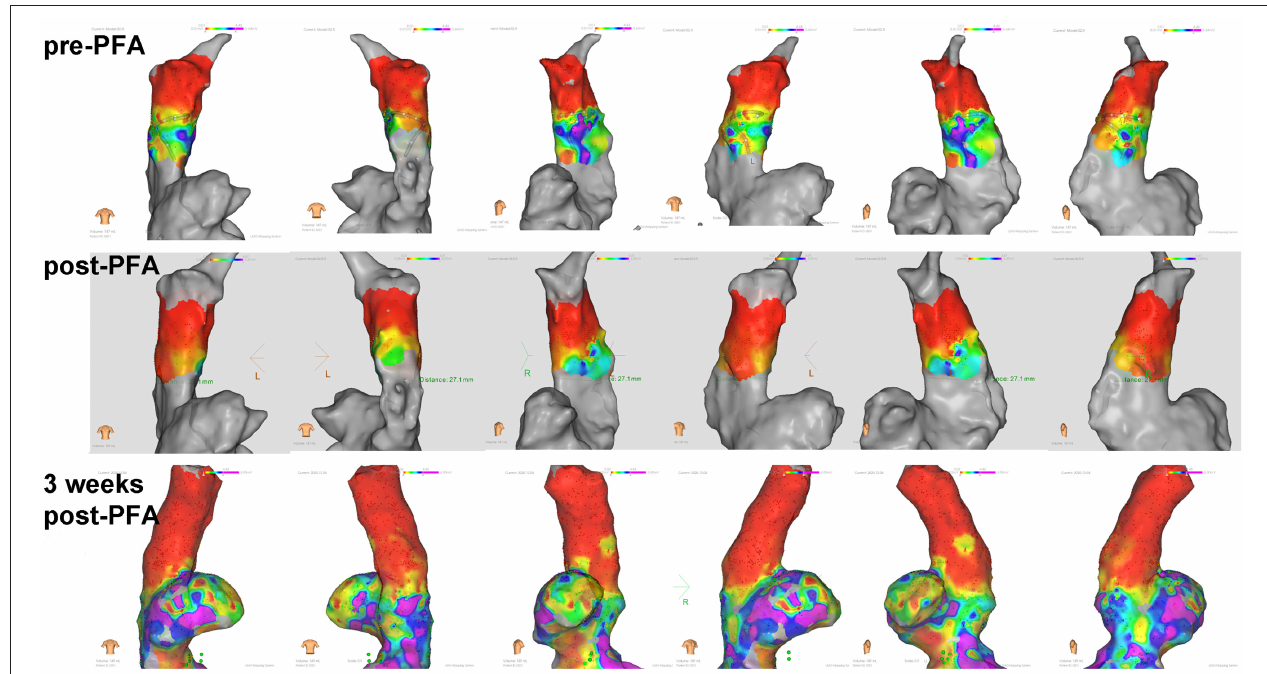
FIGURE 3 | Voltage mapping of superior vena cava in different body positions. Potential reduction was observed after ablation and during 3 weeks follow up.